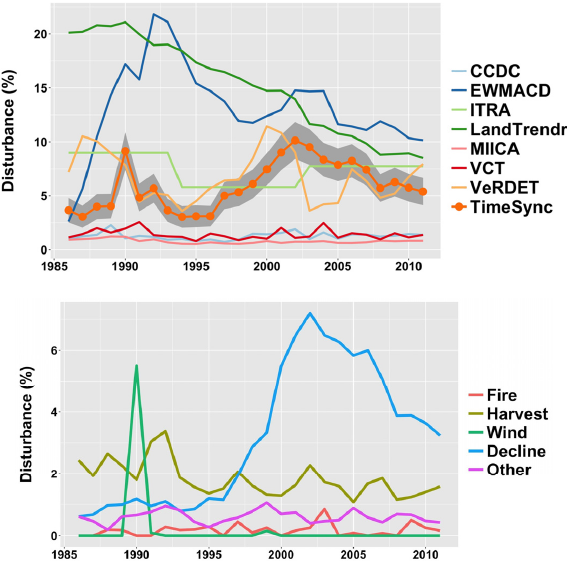
Figure 2. (Top) Aggregate (across scene) disturbance rate trajectories for maps derived from each of the seven algorithms examined in this study, and for the TimeSync reference data (with 95% confidence interval envelope); (Bottom) Aggregate disturbance rate for TimeSync data (top), by causal agent class.